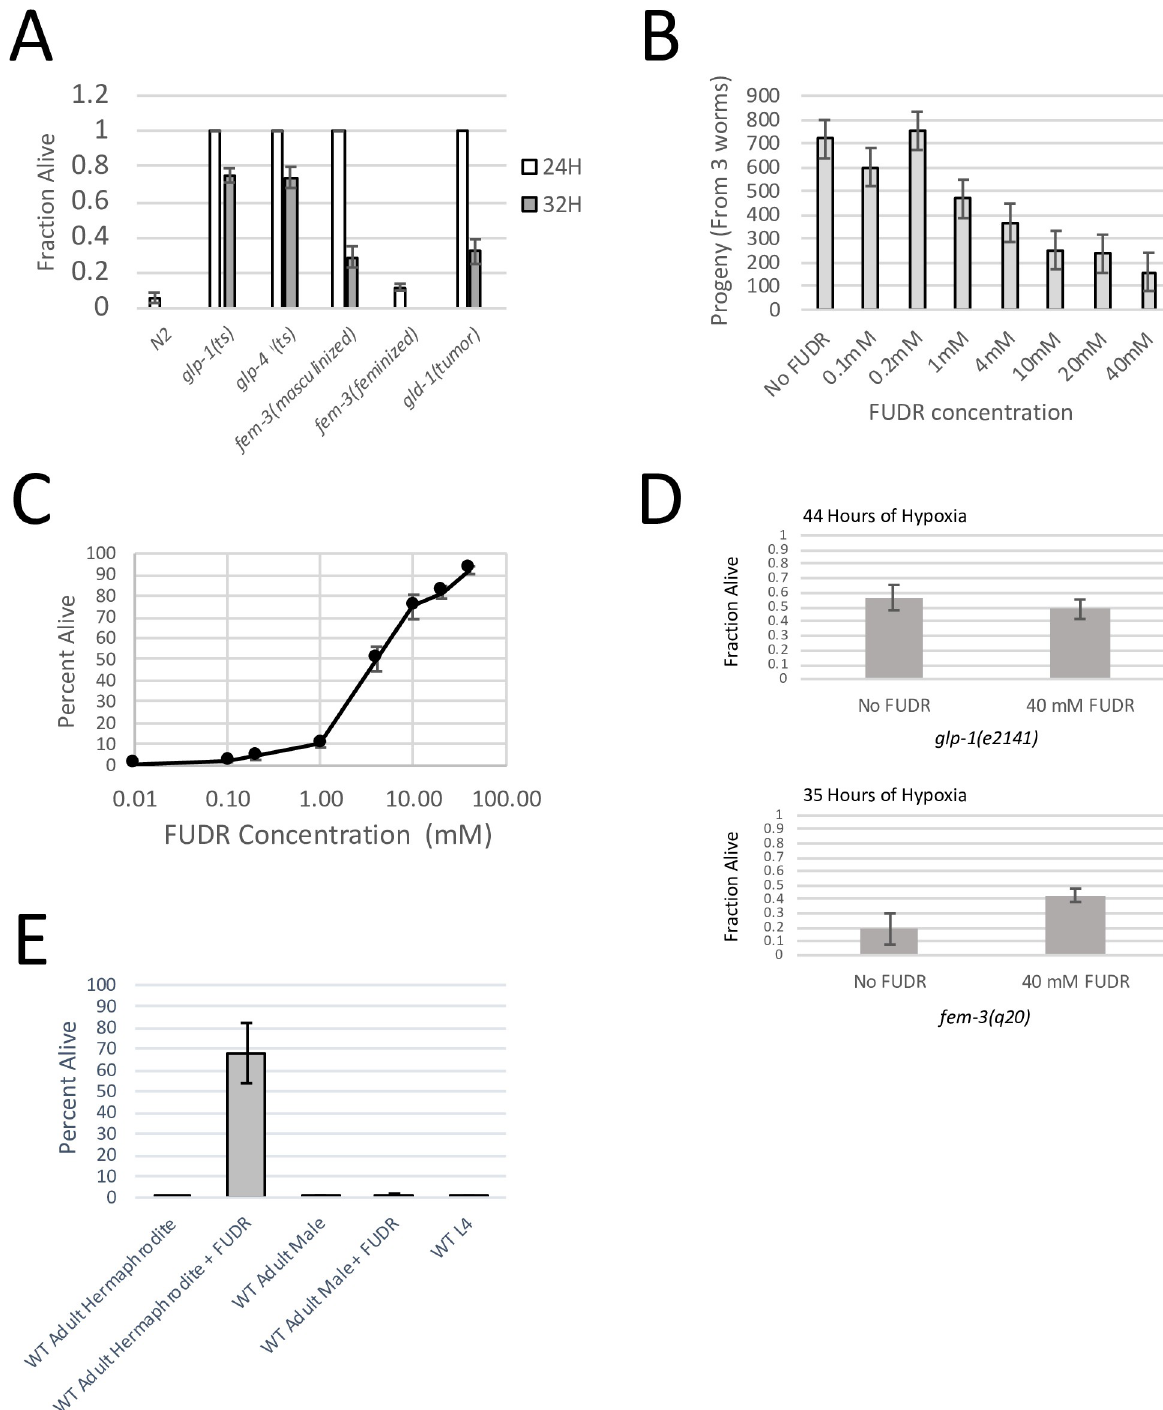
Fig 1. Hypoxia Resistance of Sterile Mutants. (A) The fraction of adult worms surviving either 24 hours or 32 hours of hypoxia at 26.5˚C. All animals were grown to adulthood at the non-permissive temperature (25˚C) to induce sterility in the germline mutants. Data show that germline ablated animals ( glp-1(ts) and glp-4(ts) ), masculinized fem-3(q20) mutants ( fem-3(masculinized) ) and gld-1(tumor) mutants are highly resistant to hypoxic injury, whereas the feminized fem-3(e2006) mutant ( fem-3(feminized) ) displays close to wild type hypoxia sensitivity. Error bars represent standard error. Data are derived from at least 6 biological replicates. (B) The average number of progeny produced by 3 WT worms when treated with different concentrations of FUDR. Data show that the brood size of WT worms decreases as they are exposed to higher concentrations of FUDR. The fertility mid-point is near 4 mM FUDR. Error bars represent standard error. Data are derived from at least 5 biological replicates (C)